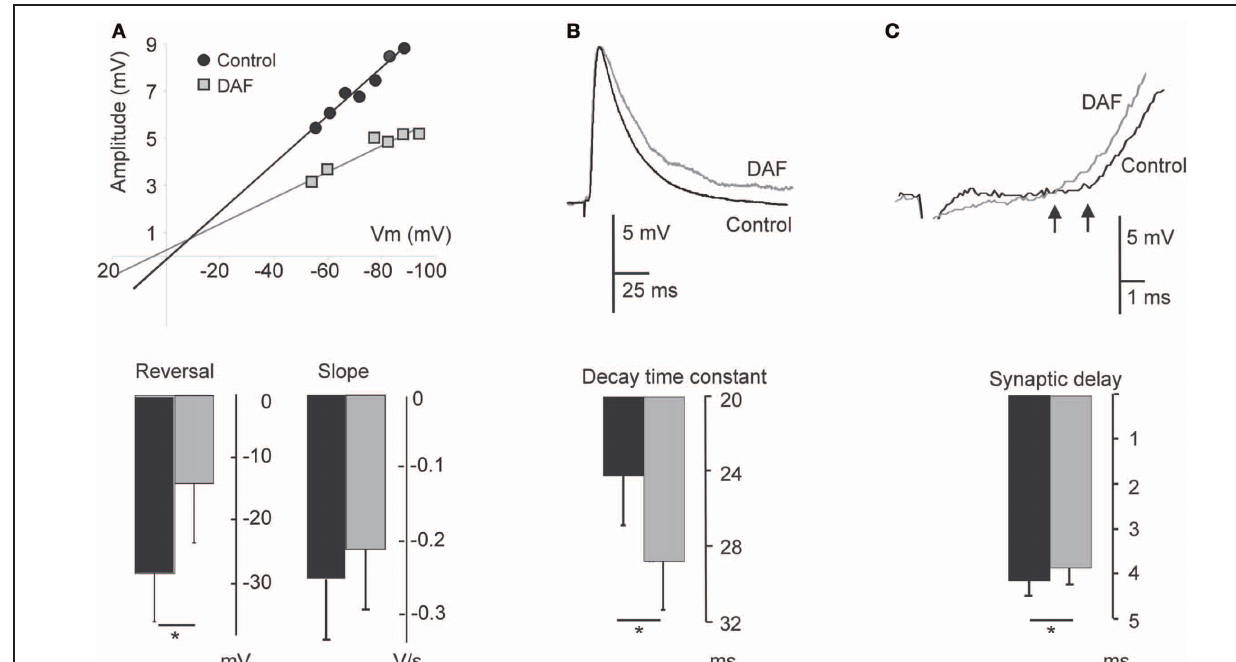
decay time (upper panel). The bottom panel displays the summary diagram of the change in the decay time constant ( n = 8). (C) Example traces of EPSPs before and after illumination, demonstrating a decrease in the delay. Arrows point to the deflection points (upper panel). The bottom panel displays a summary diagram of the change in the dendritic delay ( n = 8). For all panels, recording under control conditions are represented by black bars; recordings following illumination are represented by gray